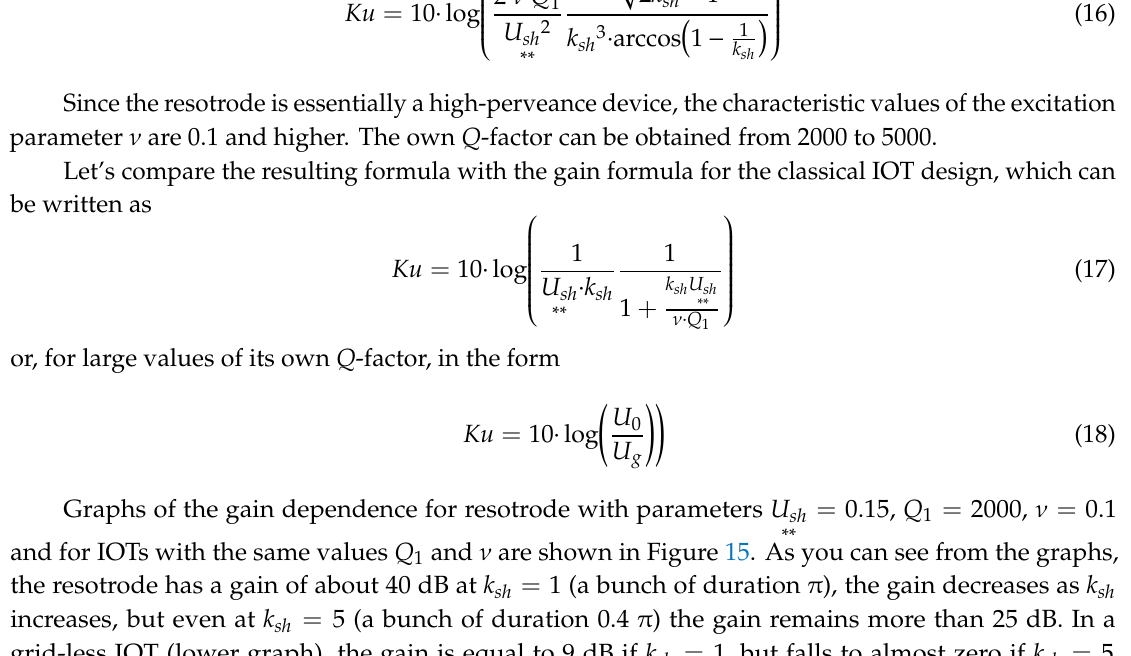
Figure 16. The dependence of the maximum electronic efficiency of resotrodes and normalized output power